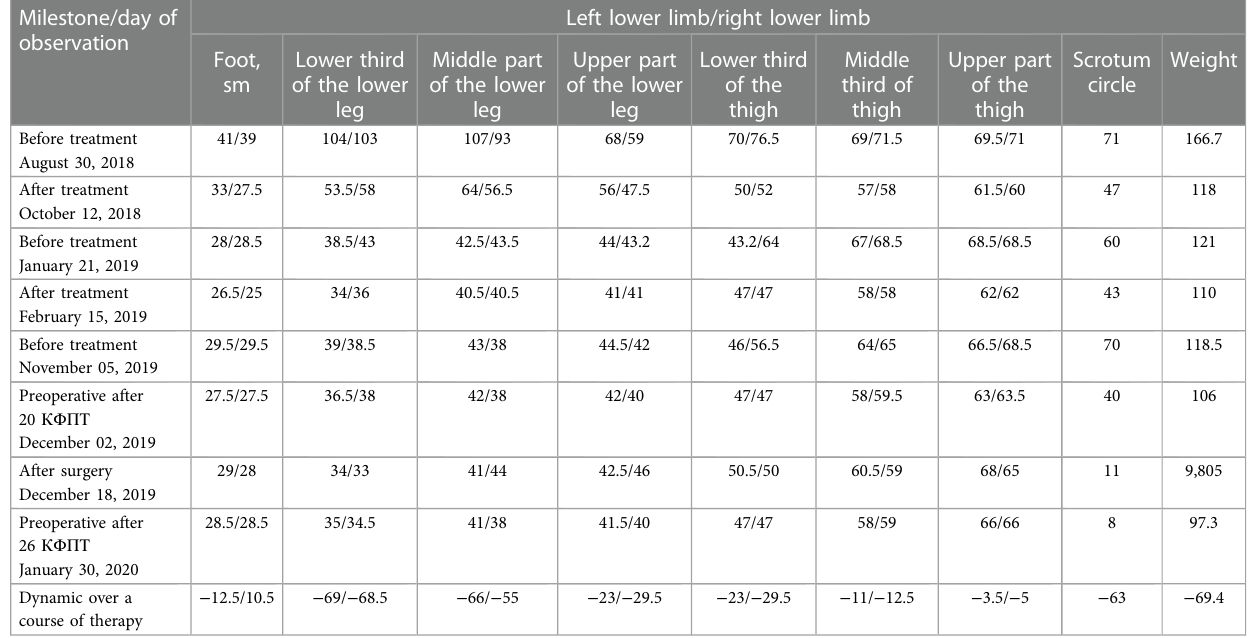
TABLE 1 Dynamics of the size of the lower extremities during the treatment period. Milestone/day